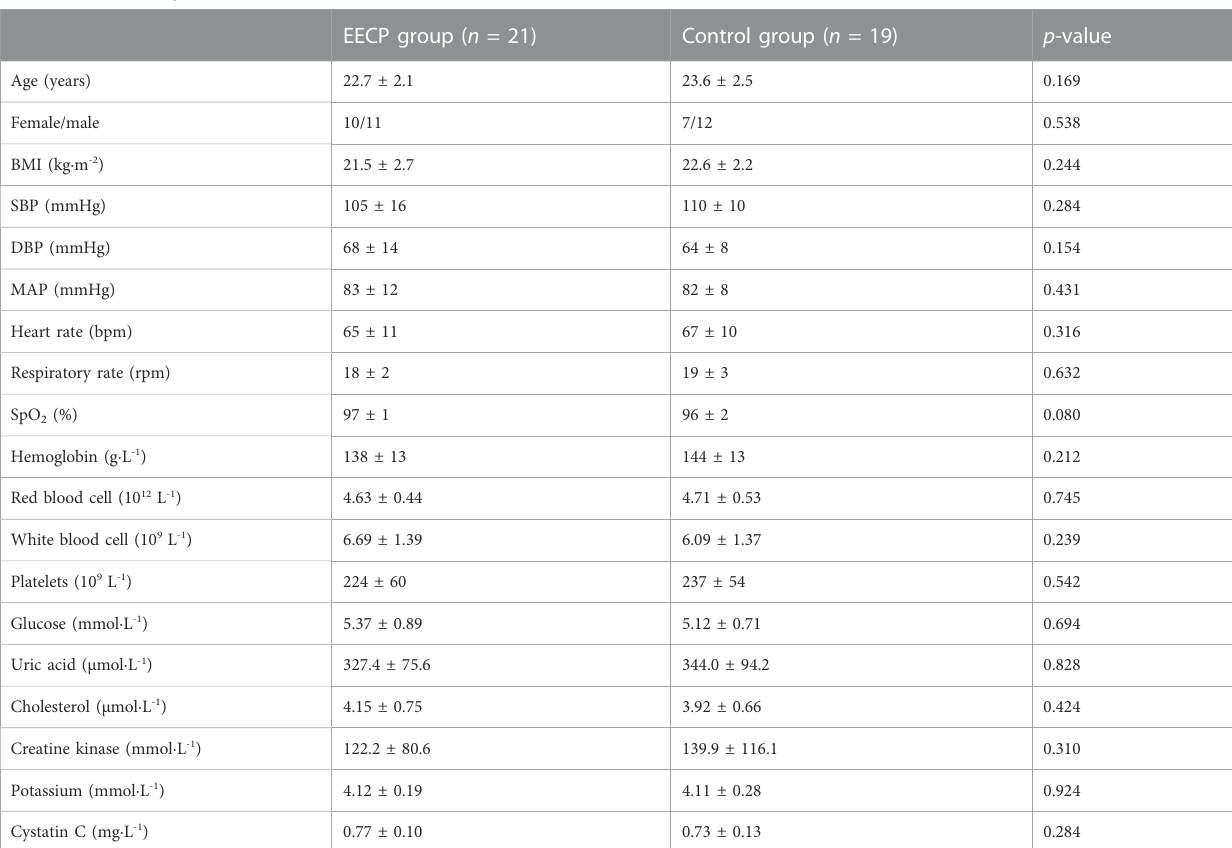
TABLE 1 Baseline sample